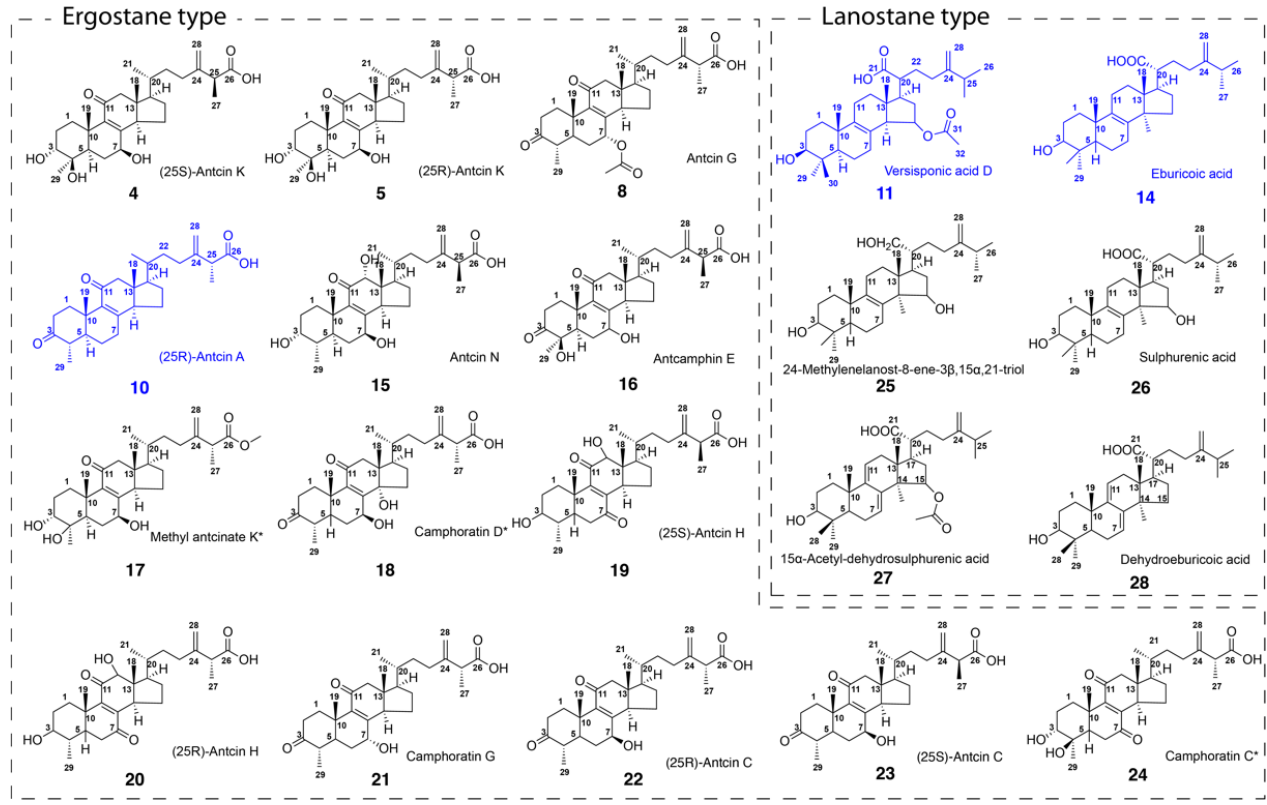
Figure 1. Structures of phytochemicals isolated from cultured Antrodia cinnamomea fruiting bodies. The blue ones are potent anti-inflammatory agents. Note: the numbers correspond to the peak numbers in the HPLC chromatogram shown in Figure 2.